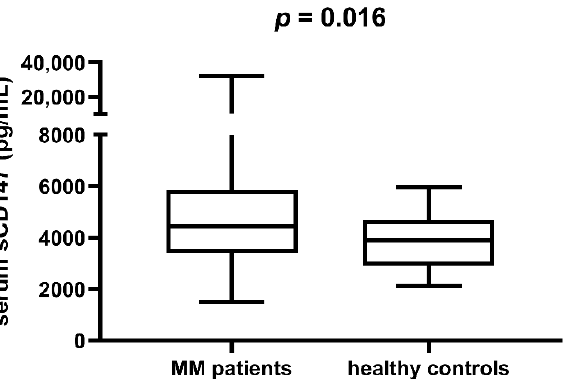
Figure 1. Serum sCD147 in multiple myeloma (MM) patients and the control group of healthy individuals. sCD147 is higher in the former group ( p = 0.016).